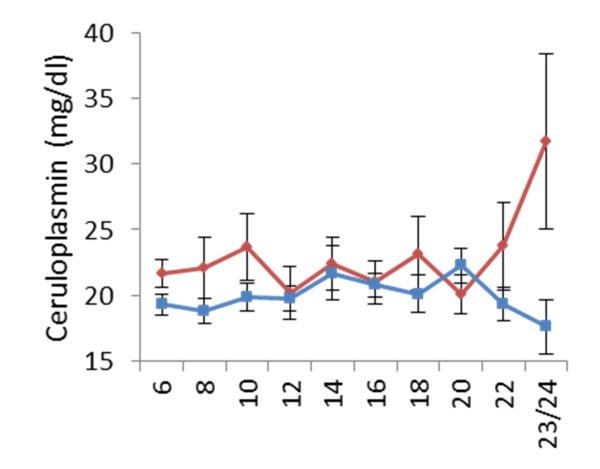
Comparison of ceruloplasmin (Cp) between healthy controls and scrapie infected sheep from six to 23/24 weeks of age. Scrapie (♦ red dotted line), controls (■ blue), Ceruloplasmin (Cp).